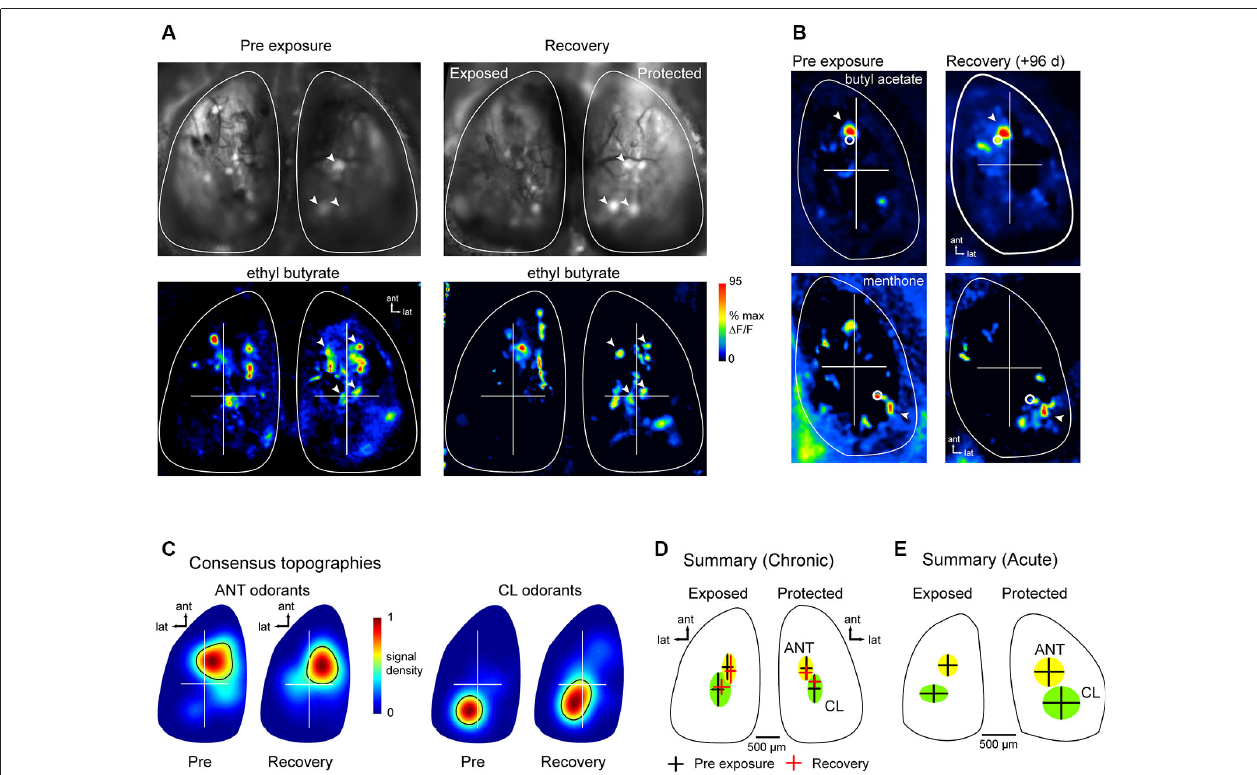
unilaterally exposed to MeBr and imaged before exposure (“Pre”) and after lesion recovery (“Recovery”). Pseudocolor scale indicates relative density of odorant-evoked spH signal across all response maps in each category. Black contour indicates arbitrary 50% cutoff of relative density plot. See the text for analysis details. (D) Quantitative analysis of response topographies in chronically-imaged mice (same animals and odorants as in (C) ). Crosshairs and shaded areas show centroid locations before lesion (black crosshairs, “Pre-exposure”) and after recovery (red crosshairs, “Recovery”) for anterior (ANT, yellow) and caudal-lateral (CL, green) odorants (See the text for list). The centers of the cross hairs denote average centroid location across all pooled odorants, with the arms and ellipses extending to 1 s.d. in x - and y -directions. Domains remained distinct for each time point and similar across time-points (note that this analysis differed slightly from that used to produce consensus topographies in (C) ; See the text for analysis details). (E) Centroid locations analyzed and plotted as in (D) for acutely-imaged animals, showing similar distribution of centroid locations for exposed and protected sides imaged in a single recovery